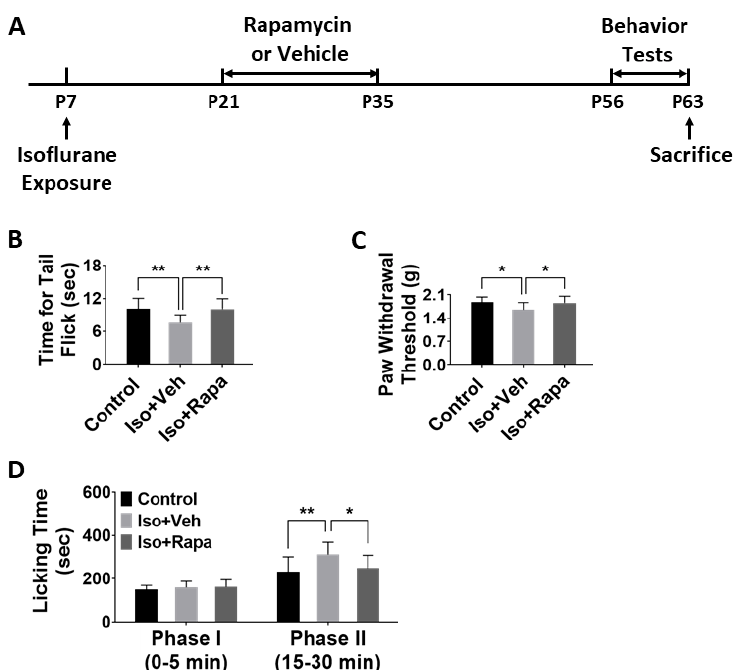
Figure 1. ( A ) Experimental timeline. At P7, two-thirds of total mice were exposed to isoflurane for 4 h and one-third of animals remained in room air as naïve control. From P21 to P35, isoflurane-exposed mice were treated with rapamycin or vehicle at 48 h intervals. The pain behavior tests were performed at P56-P62. All animals were sacrificed at P63 for immunohistochemistry (IHC) and western blotting (WB). ( B ) Tail flick test. Early isoflurane exposure caused significant decrease of tail flick latency as light beam was applied on tail. This decrease was antagonized with rapamycin treatment (one-way ANOVA). ( C ) von Frey filament test. Hind paw withdrawal threshold in isoflurane-exposed mice was significantly lower than control, which was restored with rapamycin injection (one-way ANOVA). ( D ) Formalin test. After formalin microinjection, animals in three groups spent almost identical cumulative time to lick legs or paws in phase I (0–5 min). In phase II (15–30 min), isoflurane-exposed mice had a longer licking time than control, and rapamycin reversed this e ff ect (two-way ANOVA). Iso: isoflurane; Veh: